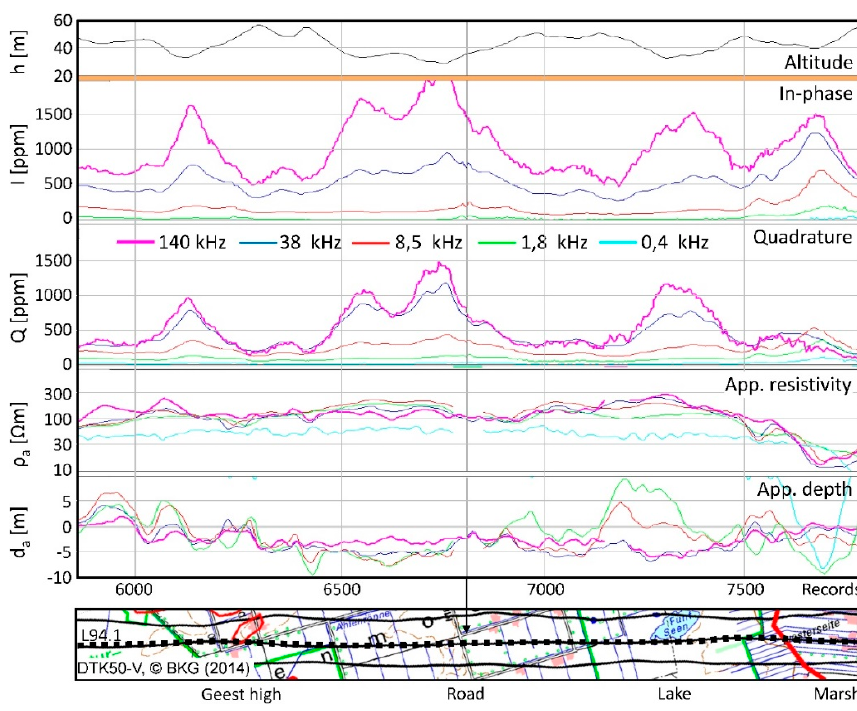
Figure 10. Helicopter-borne electromagnetics (HEM) data example along the western portion of flight line L94.1, showing (from top to bottom): HEM sensor altitude (h), in-phase (I), quadrature (Q), apparent resistivity ( ρ a ), and depth (d a ) at five frequencies (colors), as well as an extract from a flight-line map (dotted line: L94.1). The black line indicates a road, which a ff ected the HEM data (at lower frequencies). The short horizontal lines beneath the quadrature panel indicate erased data sections.